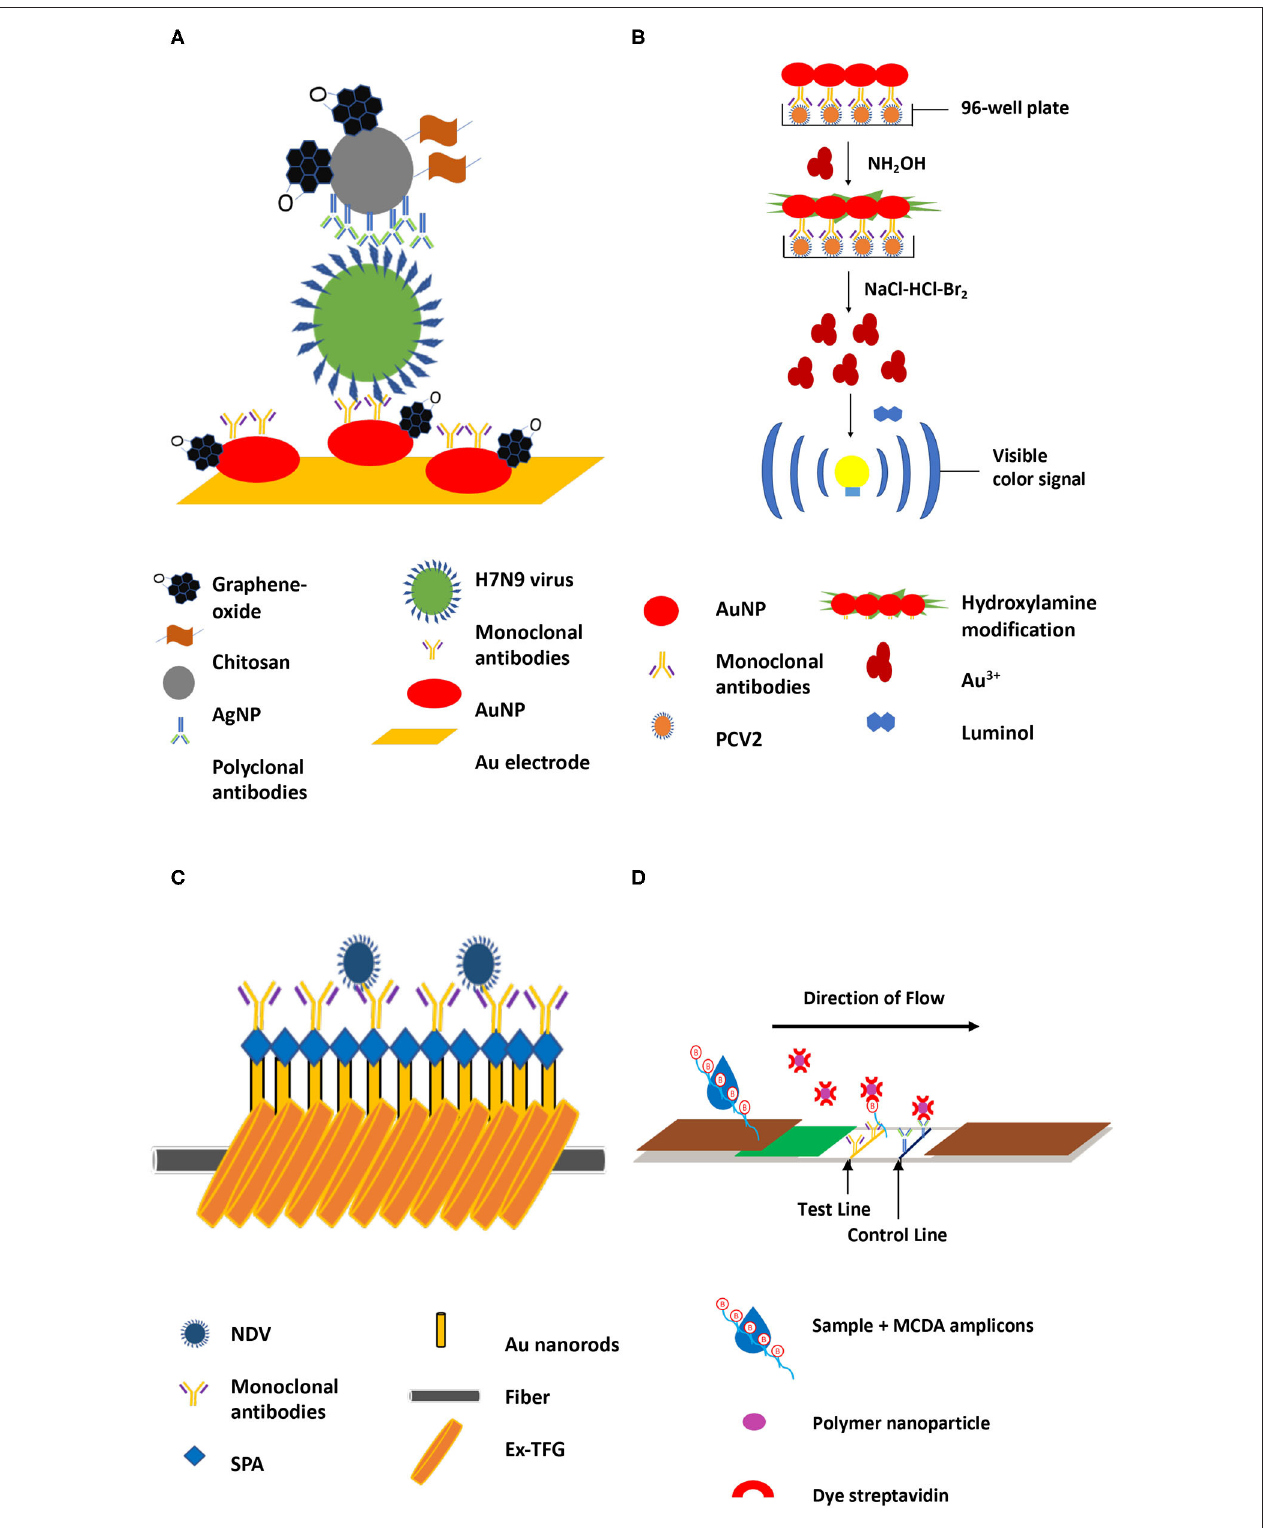
FIGURE 1 | Representative animal disease diagnostic methods incorporated with various nanomaterials. (A). Silver nanoparticles in immune-based electrochemical method targeting H7N9 virus (26). (B). Chemiluminescence immunoassay with AuNPs targeting PCV2 (27) (C). Detection of Newcastle disease through targeting ND antibodies using excessively tilted fiber grating (Ex-TFG) coated with gold nanospheres (28). (D). Polymer nanoparticle-based LFB for detecting brucellosis (29).